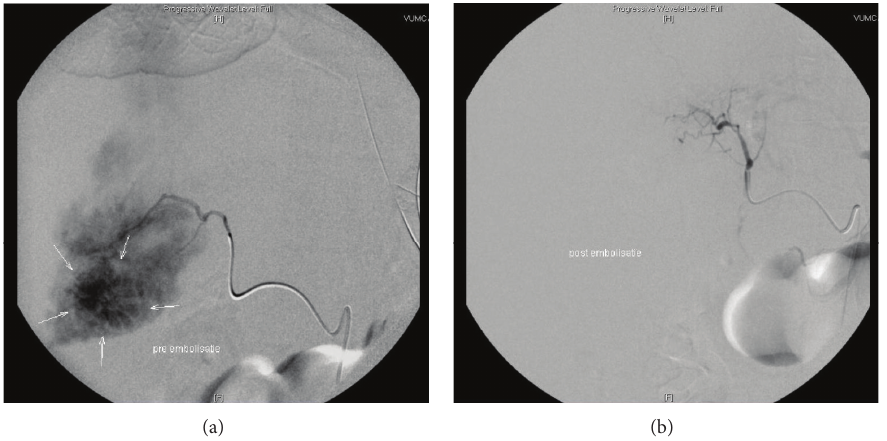
Figure 1: (a) Angiography before embolization; arrows depict the area with bleeding. (b) Angiography after embolization.